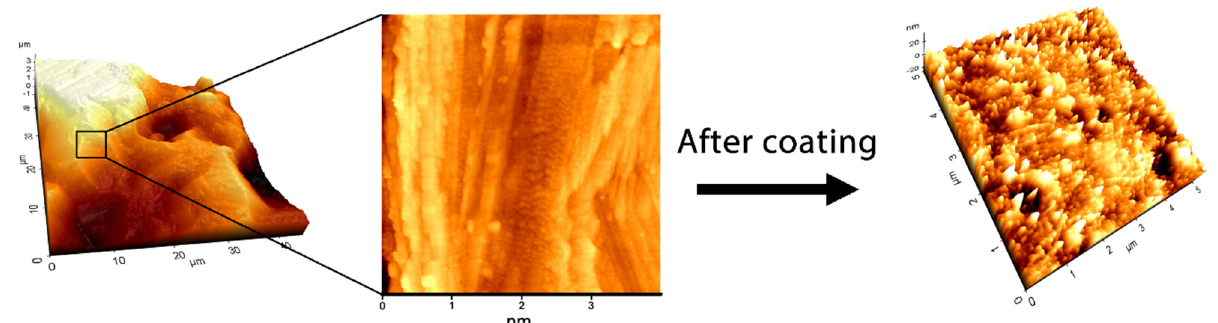
Figure 6. Atomic force microscopy (AFM) was employed to demonstrate the change in biomaterial surface roughness before and after coating. The images showed the smooth surface of the conventional titanium substrate; however, after polymeric coating, intricate nano-sized topographies can be observed on the surface of the